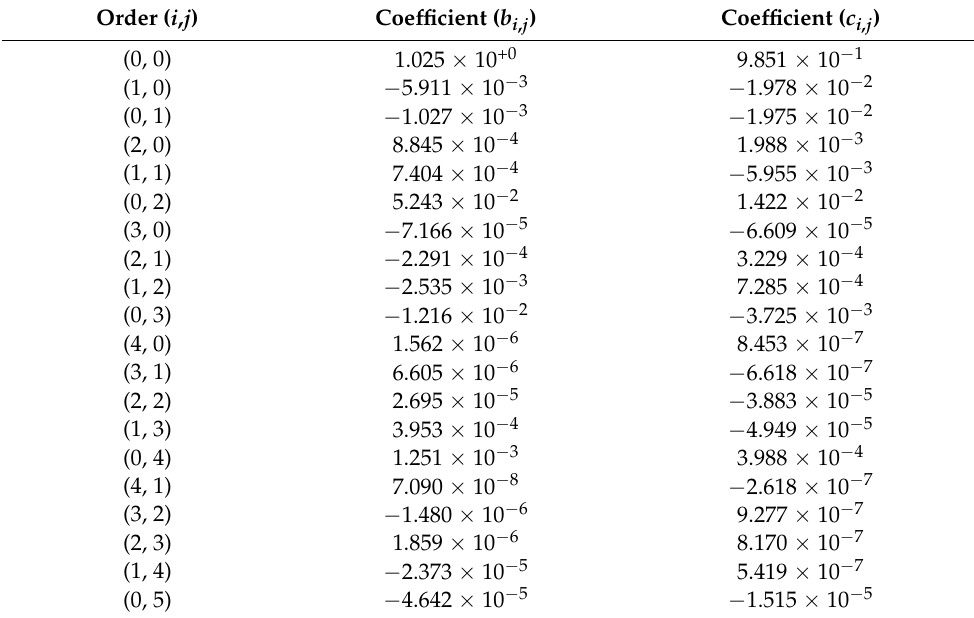
Table 3. Polynomial fitting coefficients for relaxation factors.